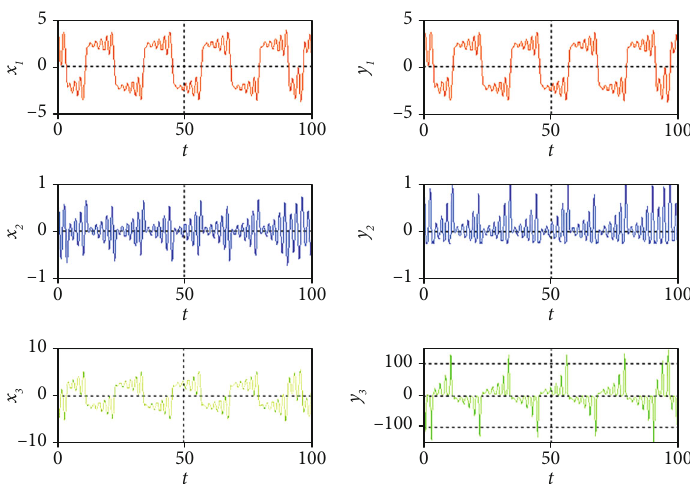
Figure 14: Time histories of di ff erent state variables in the unidirectionally coupled Chua ’ s circuit with the high-order polynomial manifold (cid:2) T , x + x 2 , x 3 y = ½ x 1 2 2 3